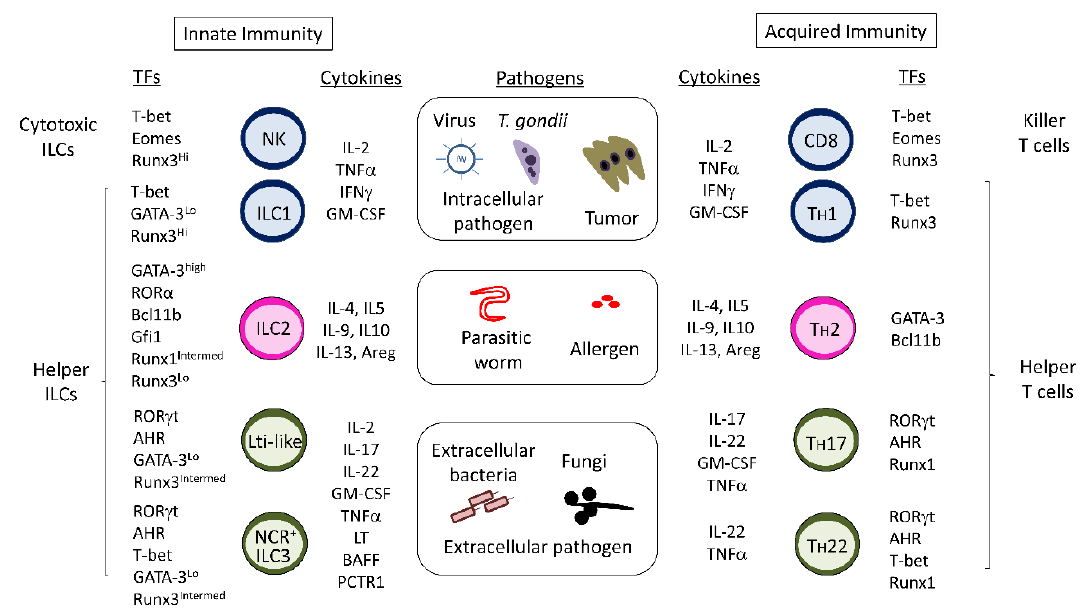
Figure 1. Similarities between innate lymphoid cells (ILCs) and T cells. TF: transcription factor.